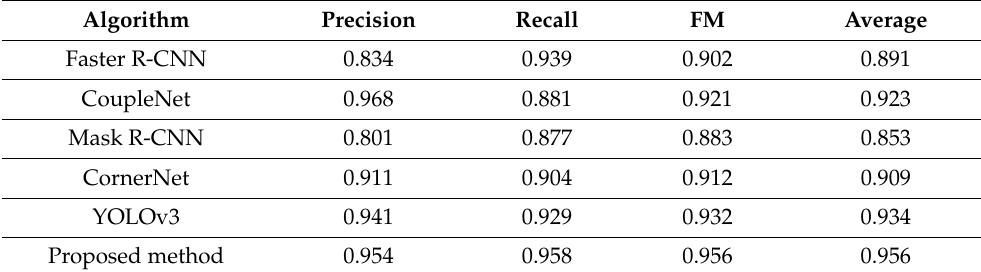
Table 4. Quantitative accuracy results of face detection and recognition methods.